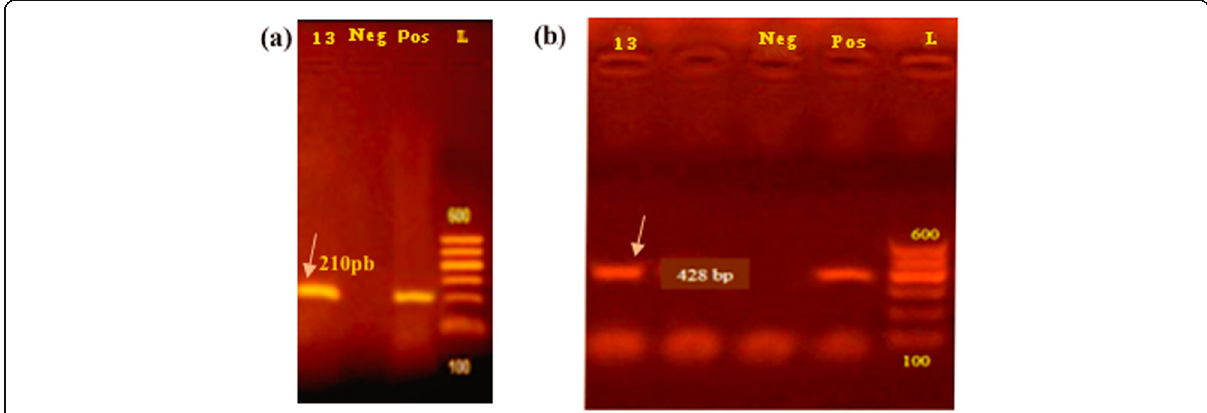
Fig. 1 Amplification products obtained from Lactic acid bacterial isolates using the rec A gene primers. a The lane product of the gene encoding Lb. plantarum indicated by the arrow. b The lane product of pln EF gene from the strain-no. 13 indicated by the arrow, using primers pairs; lane L: 1000 bp ladder. Lane Neg: negative control, Lane Pos: positive